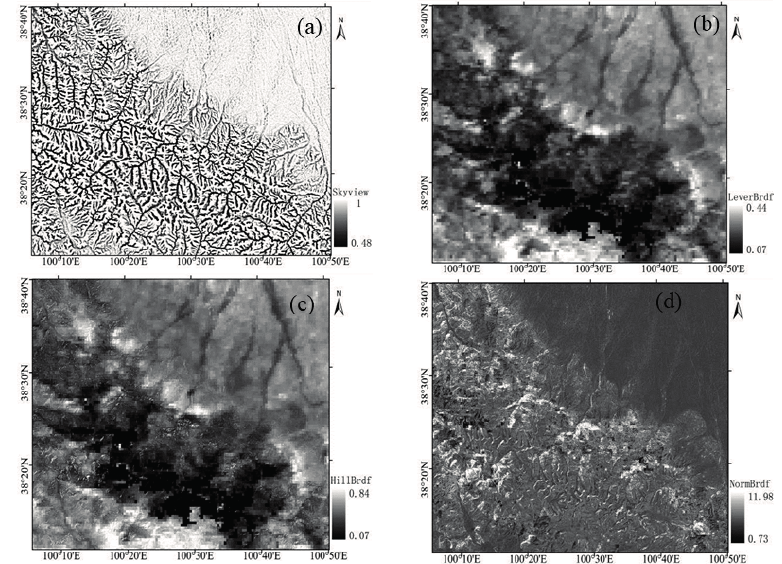
Figure 4. Sky view factor, bidirectional reflectance distribution function (BRDF) of sloping and flat pixels, and BRDF normalized factor: ( a ) sky view factor; ( b ) Level BRDF; ( c ) Hill BRDF; and ( d ) Norm